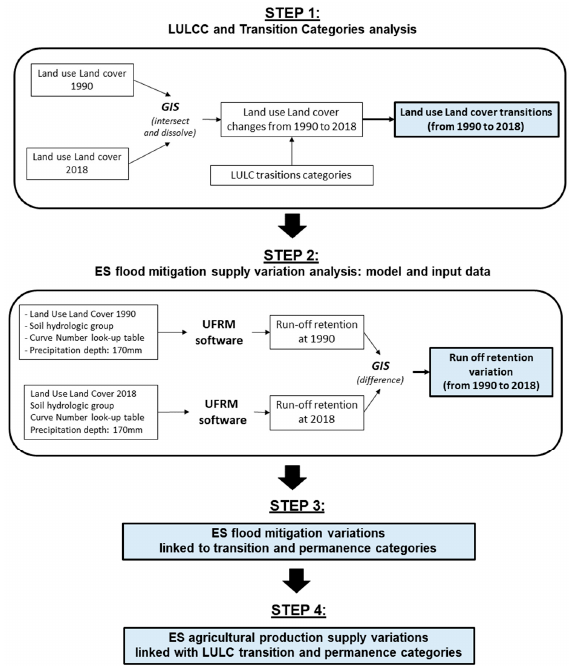
Figure 2. Methodological framework of the ecosystem services variation analysis represented by 4 steps. Sources: UFRM software [36], Land Use Land Cover [72], LULC transition categories [85], Soil hydrologic group [86], Curve Number look-up table [87].